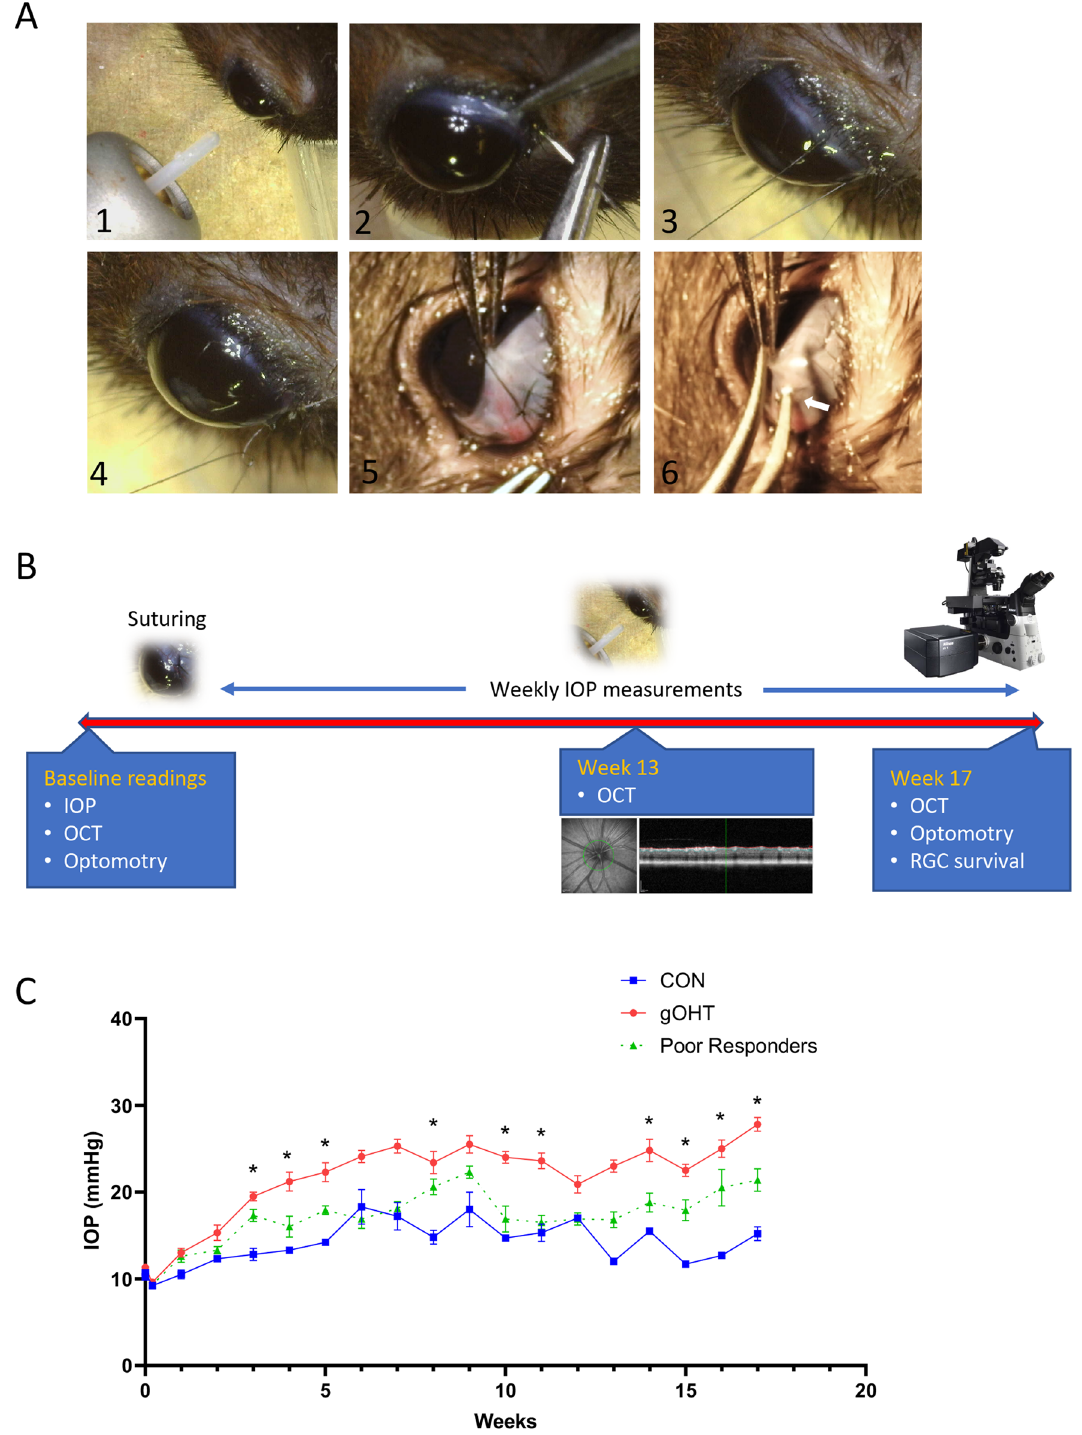
Figure 1. The snug suturing technique results in gradual and sustained ocular hypertension. ( A ) Representative pictures of the procedure; IOP is measured by rebound tonometer (1), nylon 8–0 suture was passed subconjunctivally (2, 3) and tied using a slip-knot (4) to achieve a snug fit (5). One arm of a forceps could be easily passed under the suture (white arrow), demonstrating a snug fit (6) (pictures taken with a Dino-Lite Edge Polarizing Digital Microscope). ( B ) Timeline for the associated study indicating baseline and follow-up measurements. ( C ) Average IOP curves showing significant elevation in the gOHT group compared to CON (n = 12 and 8 eyes for gOHT and CON, respectively, *p < 0.001, bars are S.E.). CON; control, gOHT; gradual ocular hypertension, IOP; intraocular pressure, OCT; optical coherence tomography, RGC; retinal ganglion